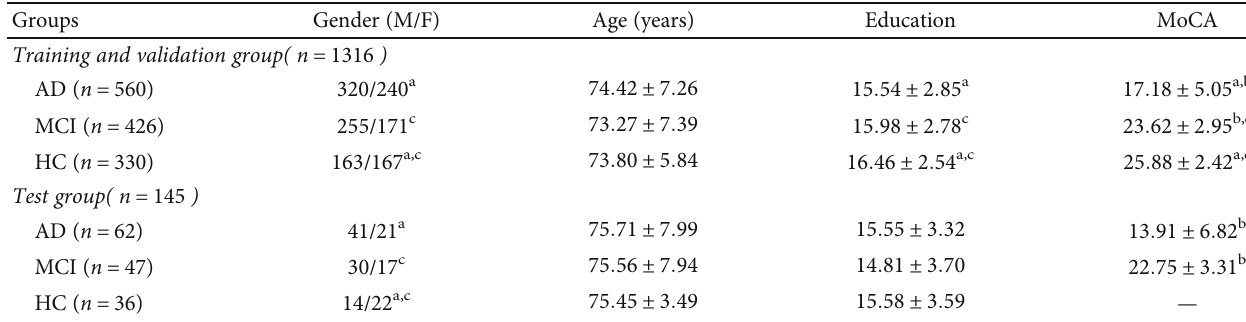
Table 1: Clinical and baseline demographic characteristics of all